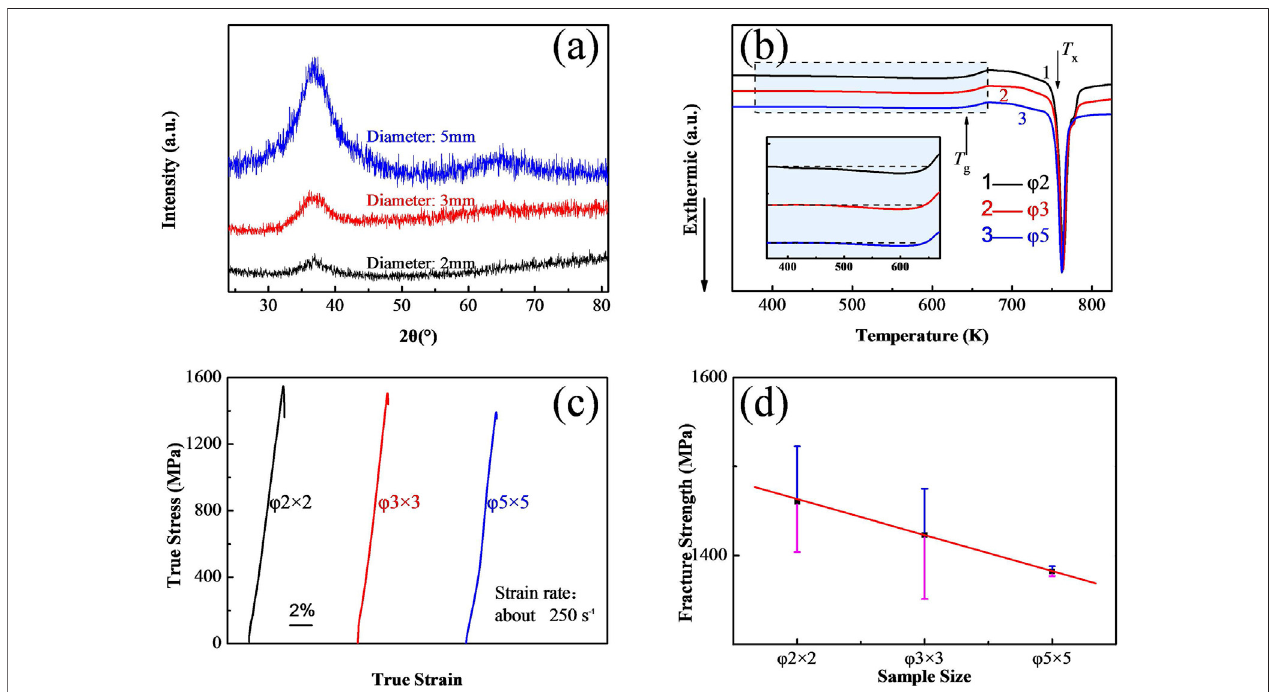
FIGURE 2| (A) the XRD patternsof Zr 65 Cu 18 Ni 7 Al 10 BMGs; (B) the DSC curves of the samples with different diameters at a heating rate of 20 K min − 1 ; (C) Typical compressiontruestressversustruestraincurvesobtainedfortheas-castZr